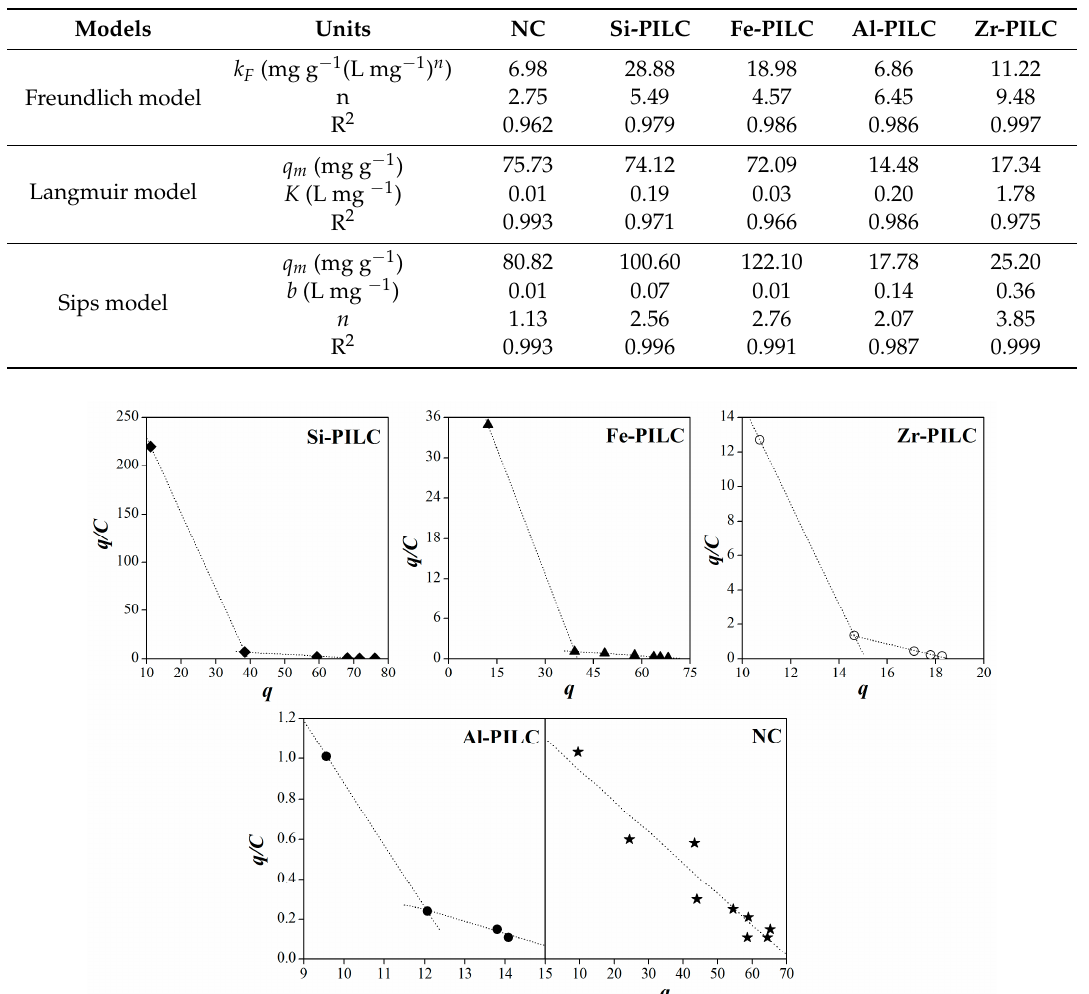
Table 2. Freundlich, Langmuir and Sips parameters for CPX adsorption on natural and pillared clay minerals.